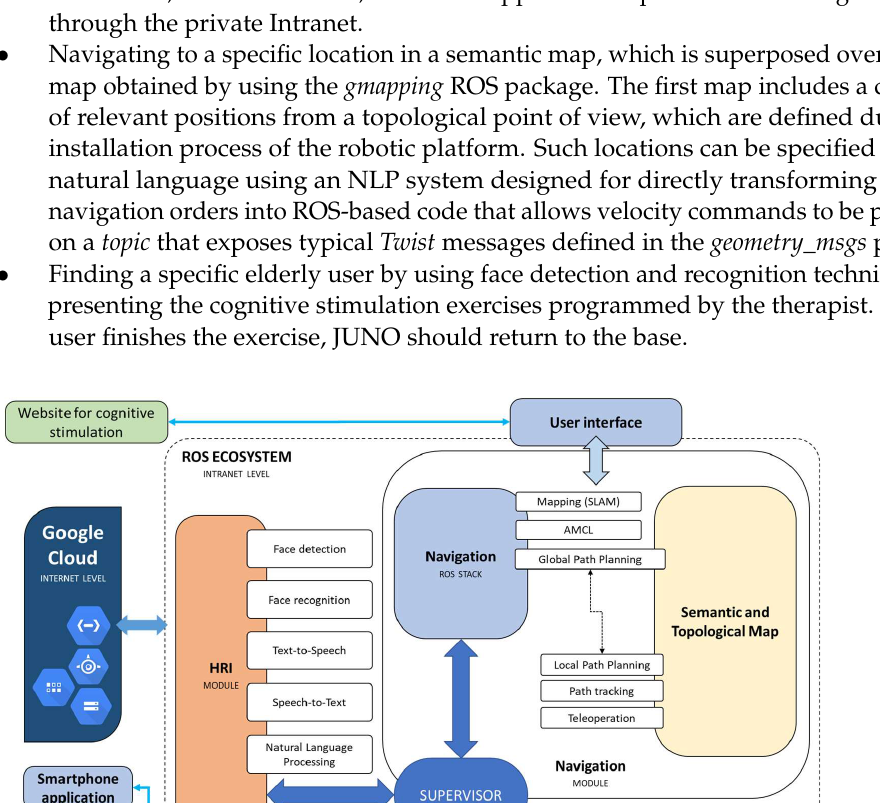
Figure 3. Standard mode of operation of the robot for helping elderly users to do their cognitive stimulation exercises. The robot stays at the base and the arrows represents the flow of tasks that the robot should accomplish from the moment that the residence worker gives an order, until the robot complete the activities and returns to the base. 2.2. Mode of Operation According to Figure 3, the activities that define the daily behavior of the robot are related to helping the selected elderly patients complete their daily cognitive stimulation exercises. The robot stays at its base until it is requested to help an elderly user with his/her exercises. Elderly users’ information has been previously uploaded during the system’s installation procedure, together with the metric and semantic maps and the DL models for each person’s face that should be automatically recognized. Furthermore, specific lo- cations in the semantic map are properly labeled, defining different points of interest, such as the base and the place where people carry out their exercises, among others.